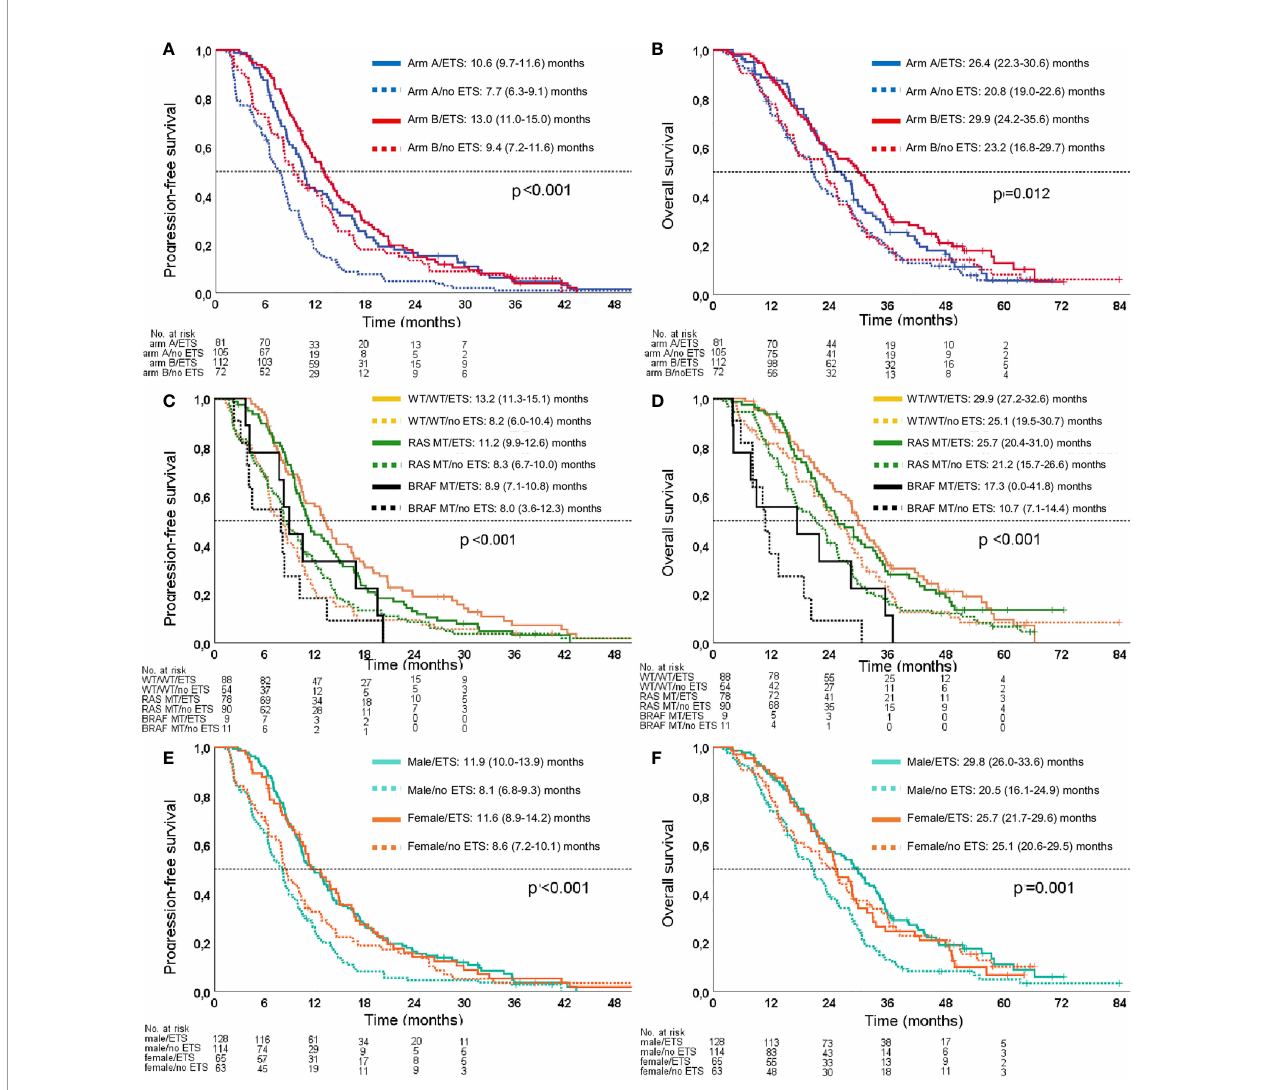
FIGURE 3 | Kaplan – Meier estimates for the association of ETS with PFS and OS. (A) Association of ETS with PFS in the study arms. (B) Association of ETS with OS in the study arms. (C) Association of ETS with PFS in molecular subgroups. (D) Association of ETS with OS in molecular subgroups. (E) Association of ETS with PFS according to sex. (F) Association of ETS with OS according to sex. Arm A: sequential treatment arm; Arm B: initial combination treatment arm; WT/WT: RAS/ BRAF WT